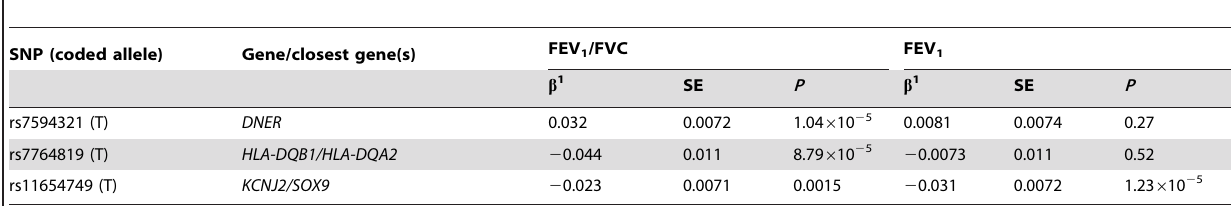
Table 2. Look-up evaluation of SNP main associations with FEV 1 /FVC and FEV 1 using data generated by our previous genome- wide association study meta-analysis (N= 48,201), for the most significant SNP from each of the three novel loci implicated at genome-wide significance in the joint